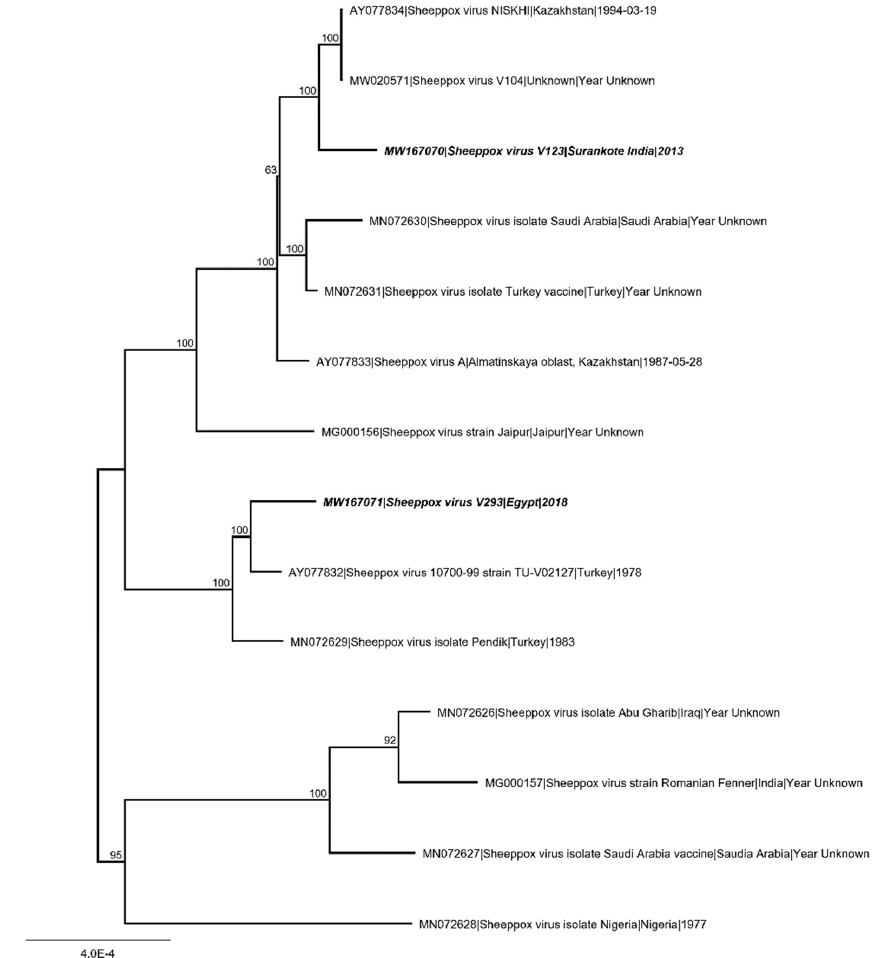
Figure 6. Phylogenetic analysis of Sheeppox virus (SPPV). Complete SPPV genome sequences were aligned using MAFFT. Subsequently, maximum likelihood analysis using RAxML, including 1000 bootstrap replicates was performed. Scale bars indicate nucleotide substitutions per site. Bold typing marks the SPPV isolates analyzed in the present study.